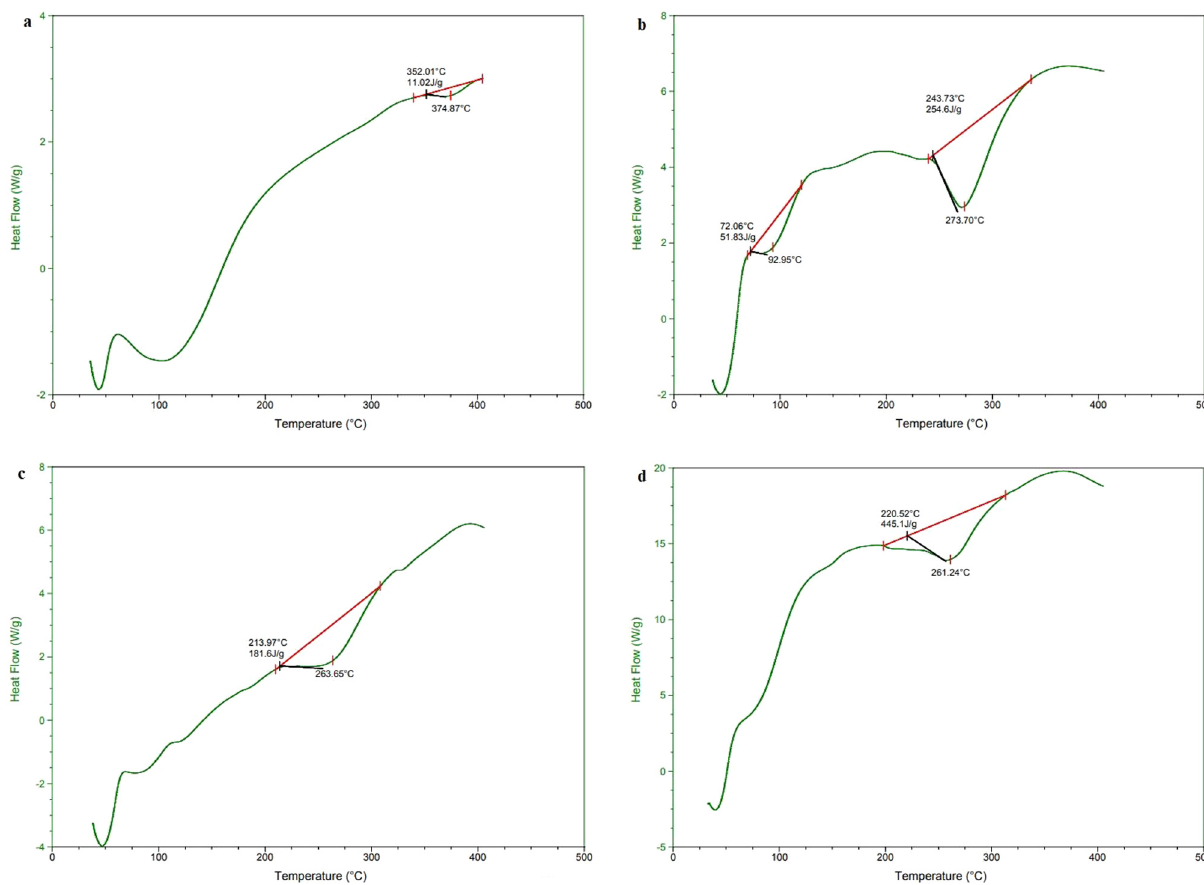
Figure 14: Di ff erential scanning calorimetry analysis of ( a ) KPA, ( b ) Mg - PA ( 0.6 g MgCl 2 ) , ( c ) PVA, and ( d ) Mg - PVA ( 0.55 g MgCl 2 )